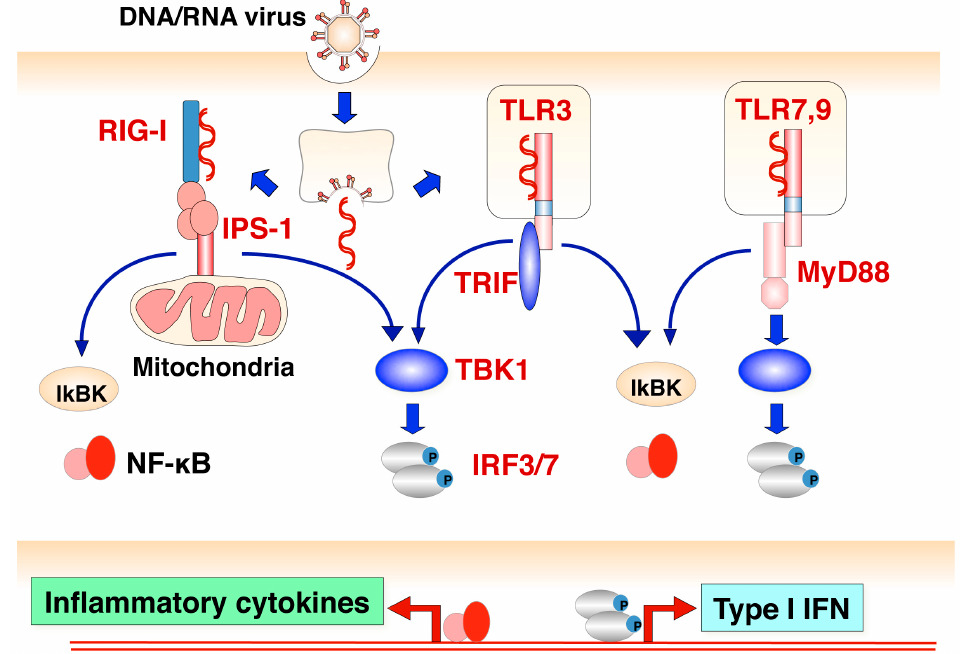
Figure 2. Induction of innate immune response by viral infection. Induction of IFN and pro-inflammatory cytokines is mainly initiated by the recognition of several viral components in mammalian cells. RIG-like receptors such as RIG-I and MDA5 (cytoplasmic sensors) recognize viral-specific double strand RNA, and then the IPS-1-mediated signaling pathway is activated. On the other hand, Toll-like receptors such as TLR9, TLR7 and TLR3 (endosomal sensors) recognize viral DNA, RNA and replicative intermediate double strand RNA, and then a TRIF- or Myd88-mediated signaling pathway is activated. Finally, these pathways trigger the activation of transcription factors such as NF- κ B and IRF3 or IRF7, followed by the production of inflammatory cytokines and Type I IFNs, respectively.